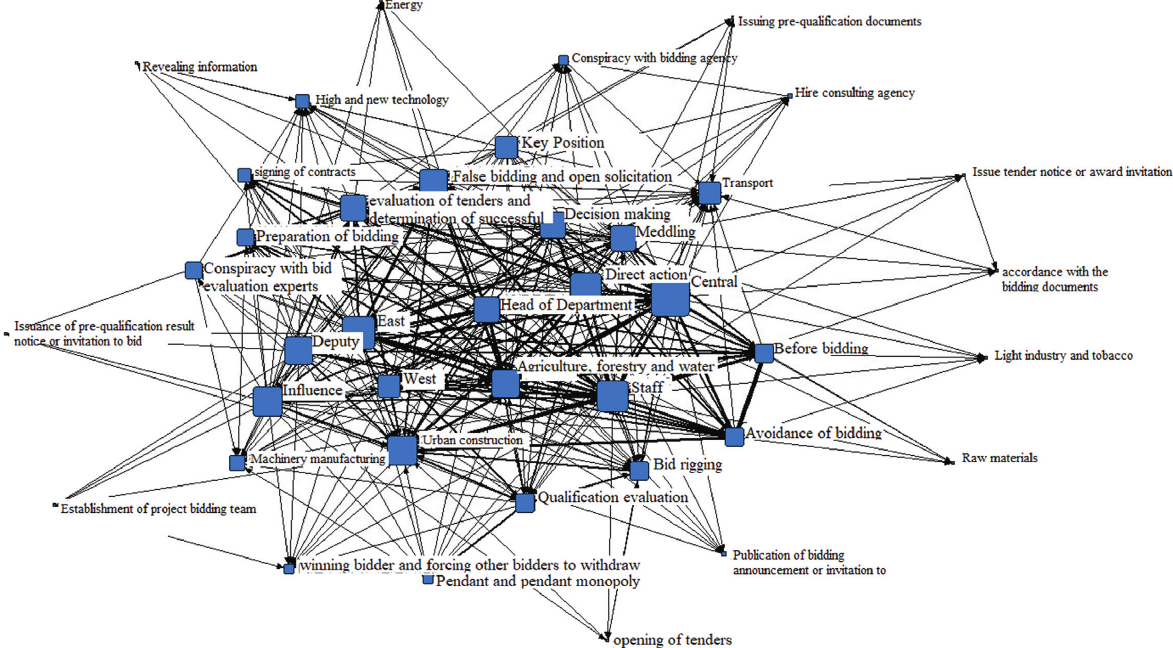
Figure 3: Analysis of co-occurrence network of each variable.